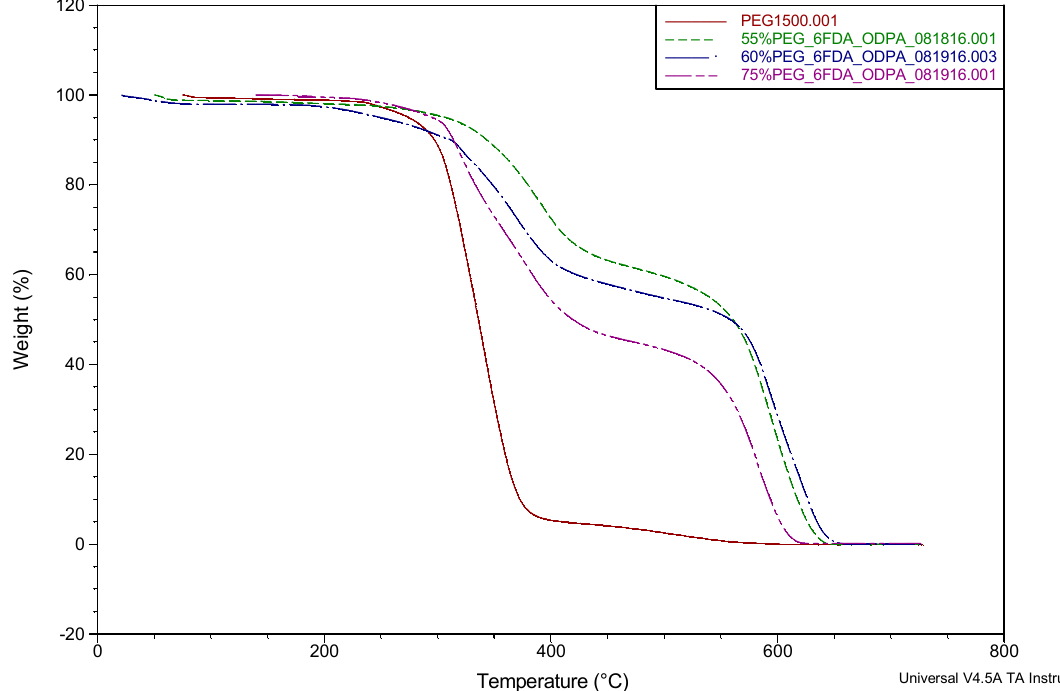
Figure 3. TGA of 6FDA + ODPA-PDODA-PEG1500 (changing PEG content) SBC membranes (percentages given in the figure for PEG content are mol%).